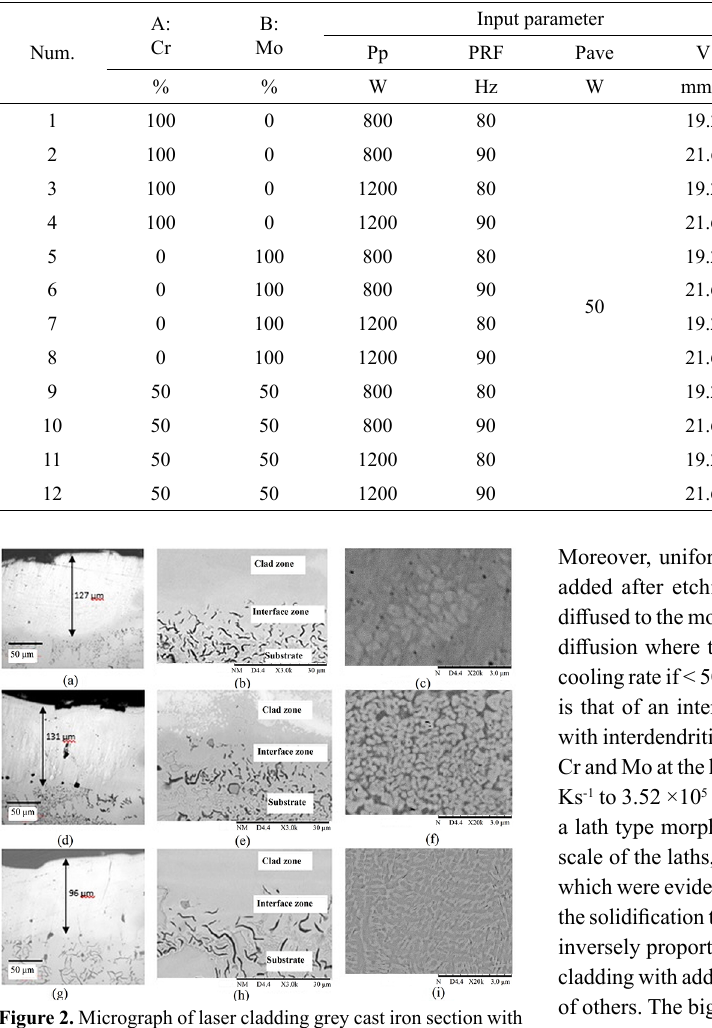
Figure 2. Micrograph of laser cladding grey cast iron section with addition of Cr powder (a) -(c), Mo powder (d) - (f) and Cr-Mo mixture powder (g) -